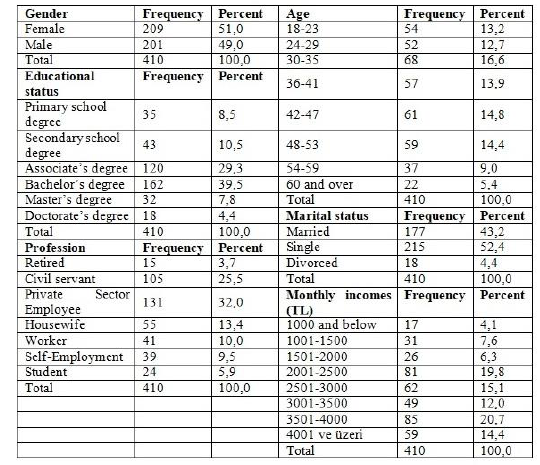
Table 1. Demographics of Consumers